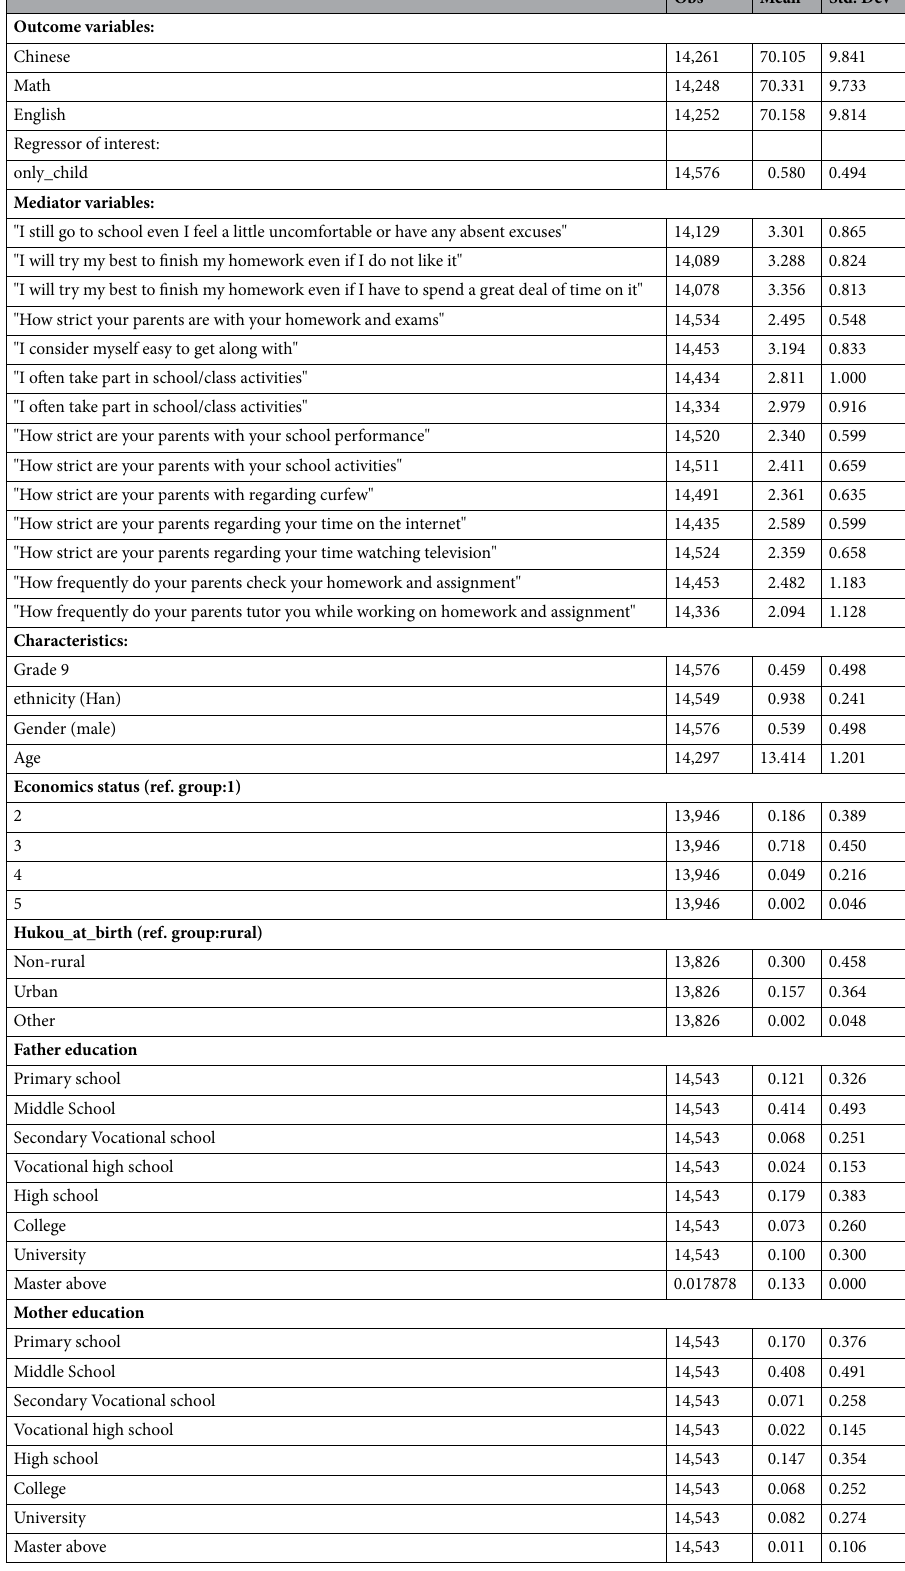
Table 1. Summary